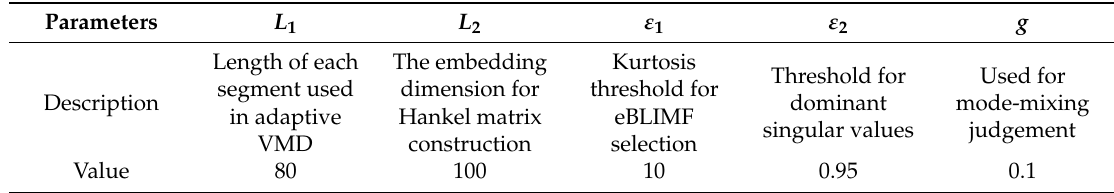
Table 2. Parameters of AVMDSSA.